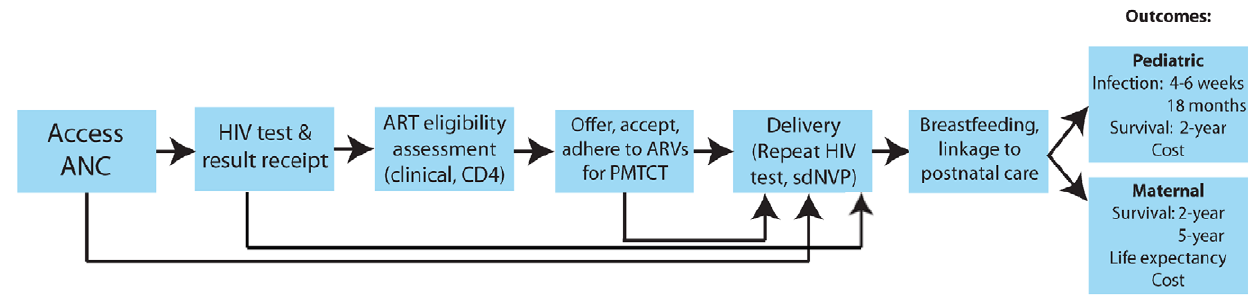
Figure 1. ‘‘Cascade’’ of PMTCT and postnatal HIV care. Opportunities to maximize the effectiveness of PMTCT interventions may be lost at each step in the pathway. ANC: antenatal care, ARVs: antiretroviral drugs, ART: antiretroviral therapy, sdNVP: single-dose